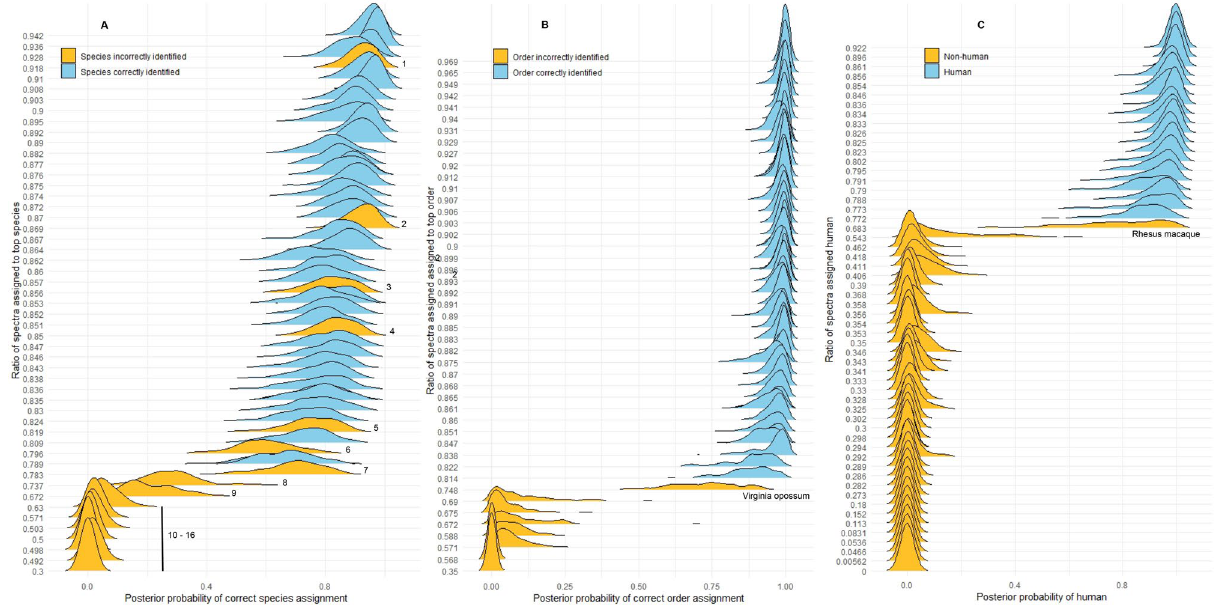
Figure 7. Predictive posterior distributions for species, order, and human origin of samples from exact leave- one-out cross validation. ( A ) Predictive posterior distributions of correct species assignment using spectra ratios from a mammalian database search. Wider, flatter distributions reflect greater uncertainty in the model for these values. Mammal bones for which species was incorrectly identified by spectra ratio are: 1, 2, 4, and 8 = Virginia white-tailed deer, 3 = brown bear, 5 = woodchuck, 6 = Northern river otter, 7 = grey squirrel, and 9 = Virginia opossum, all of which are species poorly represented in the database (See Supplemental Table S5). 10–16 are the seven non-mammals (see Supplemental Table S9). ( B ) Predictive posterior distributions of correct order assignment using spectra ratios from a mammalian database search. The seven non-mammalian samples were incorrectly identified by mammalian database search all have very low predicted probability of correct order assignment (bottom left, in orange). The orders of all mammals are correctly identified by spectra ratio except Virginia opossum (order Didelphimorphia), which was identified as order Dasyuromorphia. ( C ) Predictive posterior distributions of human origin using human spectra ratios from a vertebrate database search. Correctly identified human samples have narrow distributions with high predicted probability of human origin, and are clearly separated from non-human samples with very low probabilities. The only exception and the only non- human primate in the dataset, rhesus monkey, stretches from the bottom right (orange) to center of the